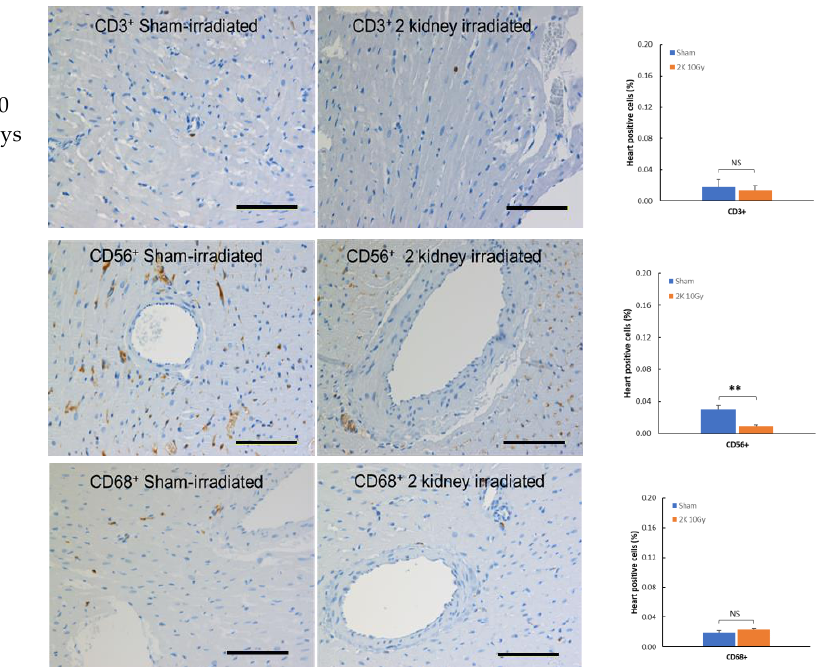
Figure 3. Immune cells in heart 120 days after local irradiation of kidneys with 10 Gy of X-rays in wild-type rat. T cells (CD3 + ), natural killer cells (CD56 + ), and macrophages (CD68 + ) appear as brown color. The horizontal scale bar represents 100 microns. Images are representative data from 3–4 animals per group. Quantification of immune cells in heart. Data are mean + SEM. ** = p < 0.01 vs. sham-irradiated control.